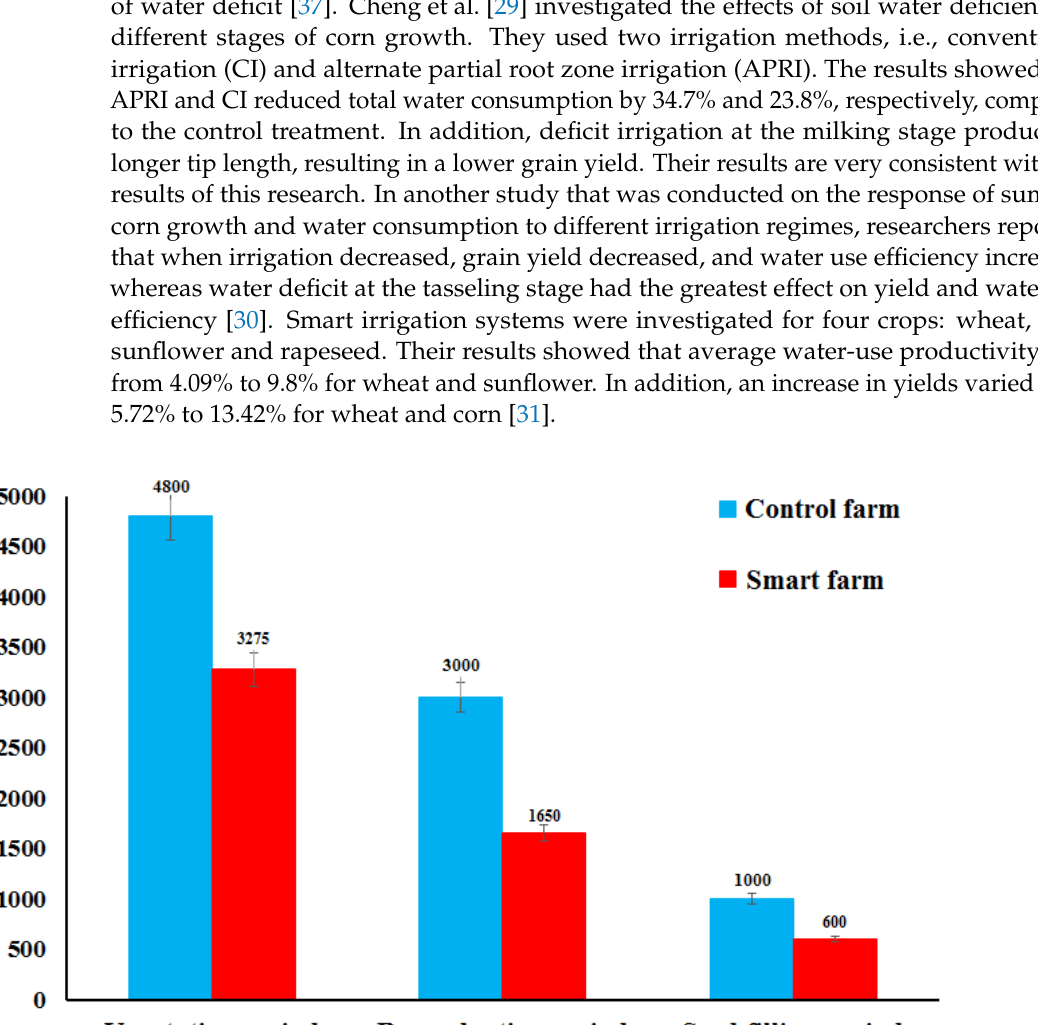
Figure 4. Irrigation water quantity in the three phases of growth, reproduction, and seed maturity.